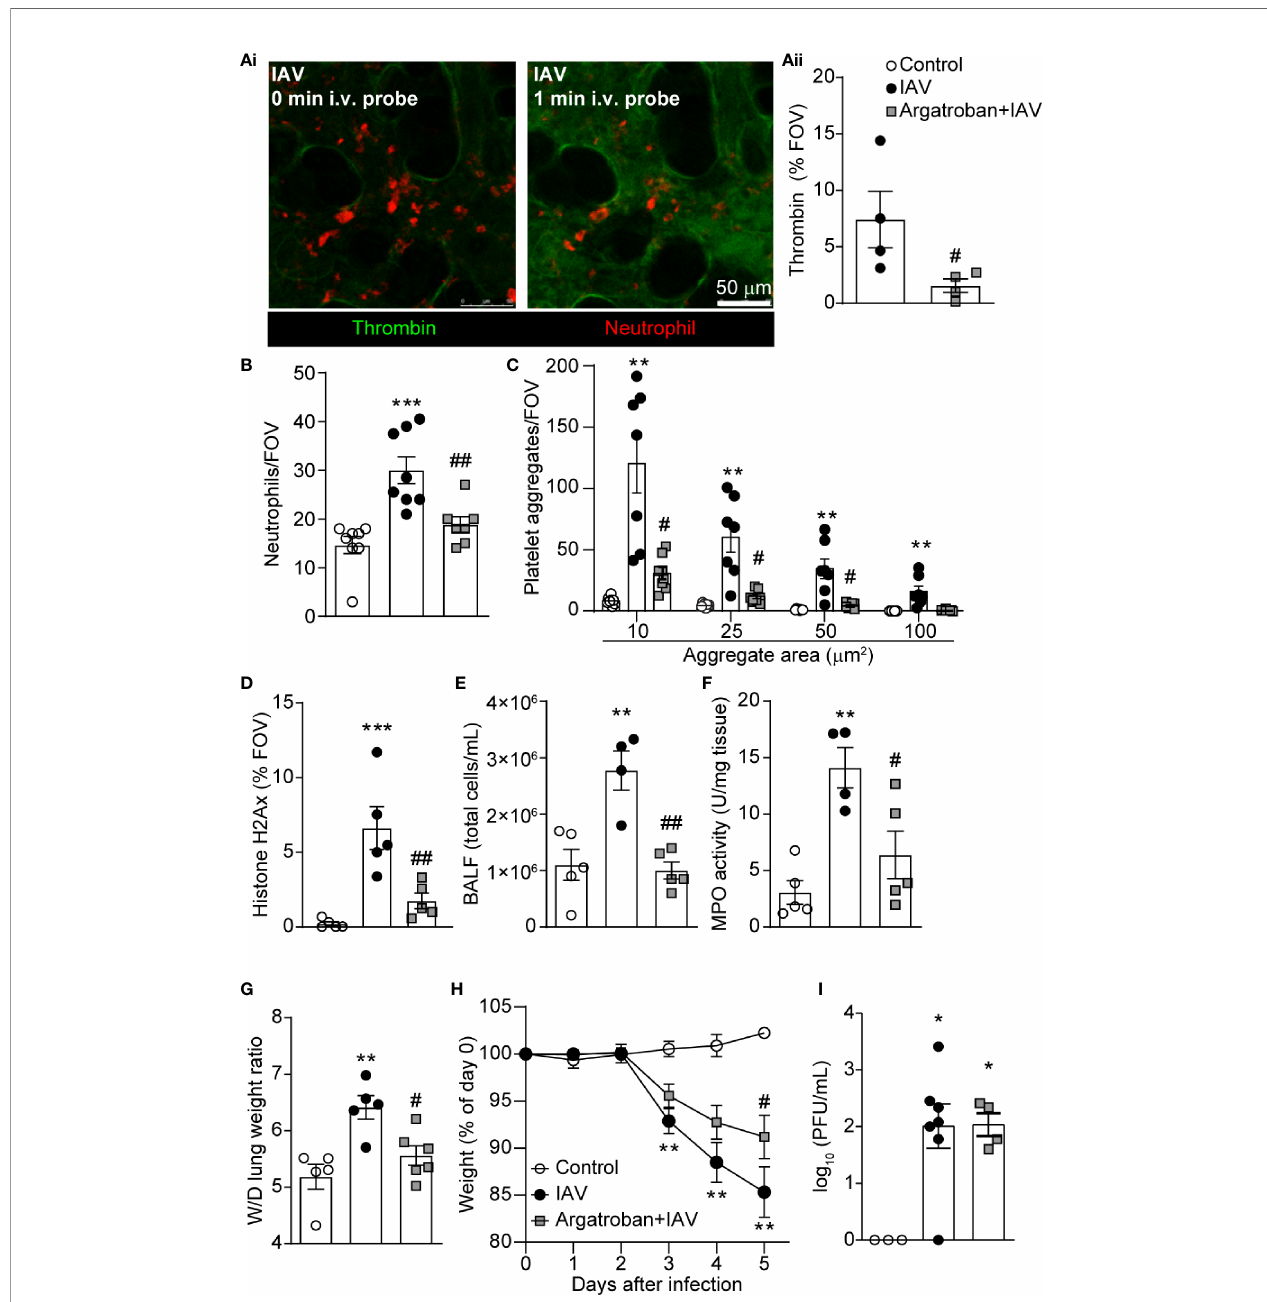
FIGURE 4 | Thrombin Mediates Platelet Aggregation and NET Release within the Lung Vasculature during IAV Infection. (Ai) Representative IVM images of thrombin probe cleavage in the mouse lung 5d-post IAV-infection at the time of probe infusion (0 min, left) and 1 min after probe infusion (right; neutrophils, red; thrombin activity, green). (Aii) Quanti fi cation of thrombin activity measured as a % of the FOV labelled by the fl uorescent substrate in IAV-infected control and argatroban- pretreated animals. Quanti fi cation of neutrophils (B) , platelet aggregation (C) , extracellular histone (D) , BALF cellularity (E) , lung MPO activity (F) , lung wet-to-dry tissue weight ratios (G) , animal body mass (H) and viral loads (I) in IAV-infected control and argatroban-pretreated mice. Values represent the mean +/- SEM. n=4-8 per group. *p < 0.05, **p < 0.01, ***p < 0.001 compared to the control group. # p < 0.05, ## p < 0.01 compared to the IAV-infected